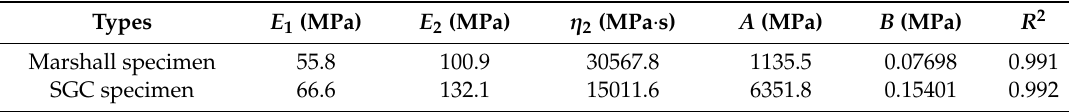
Table 6. Fitting parameters of modified Burgers model.